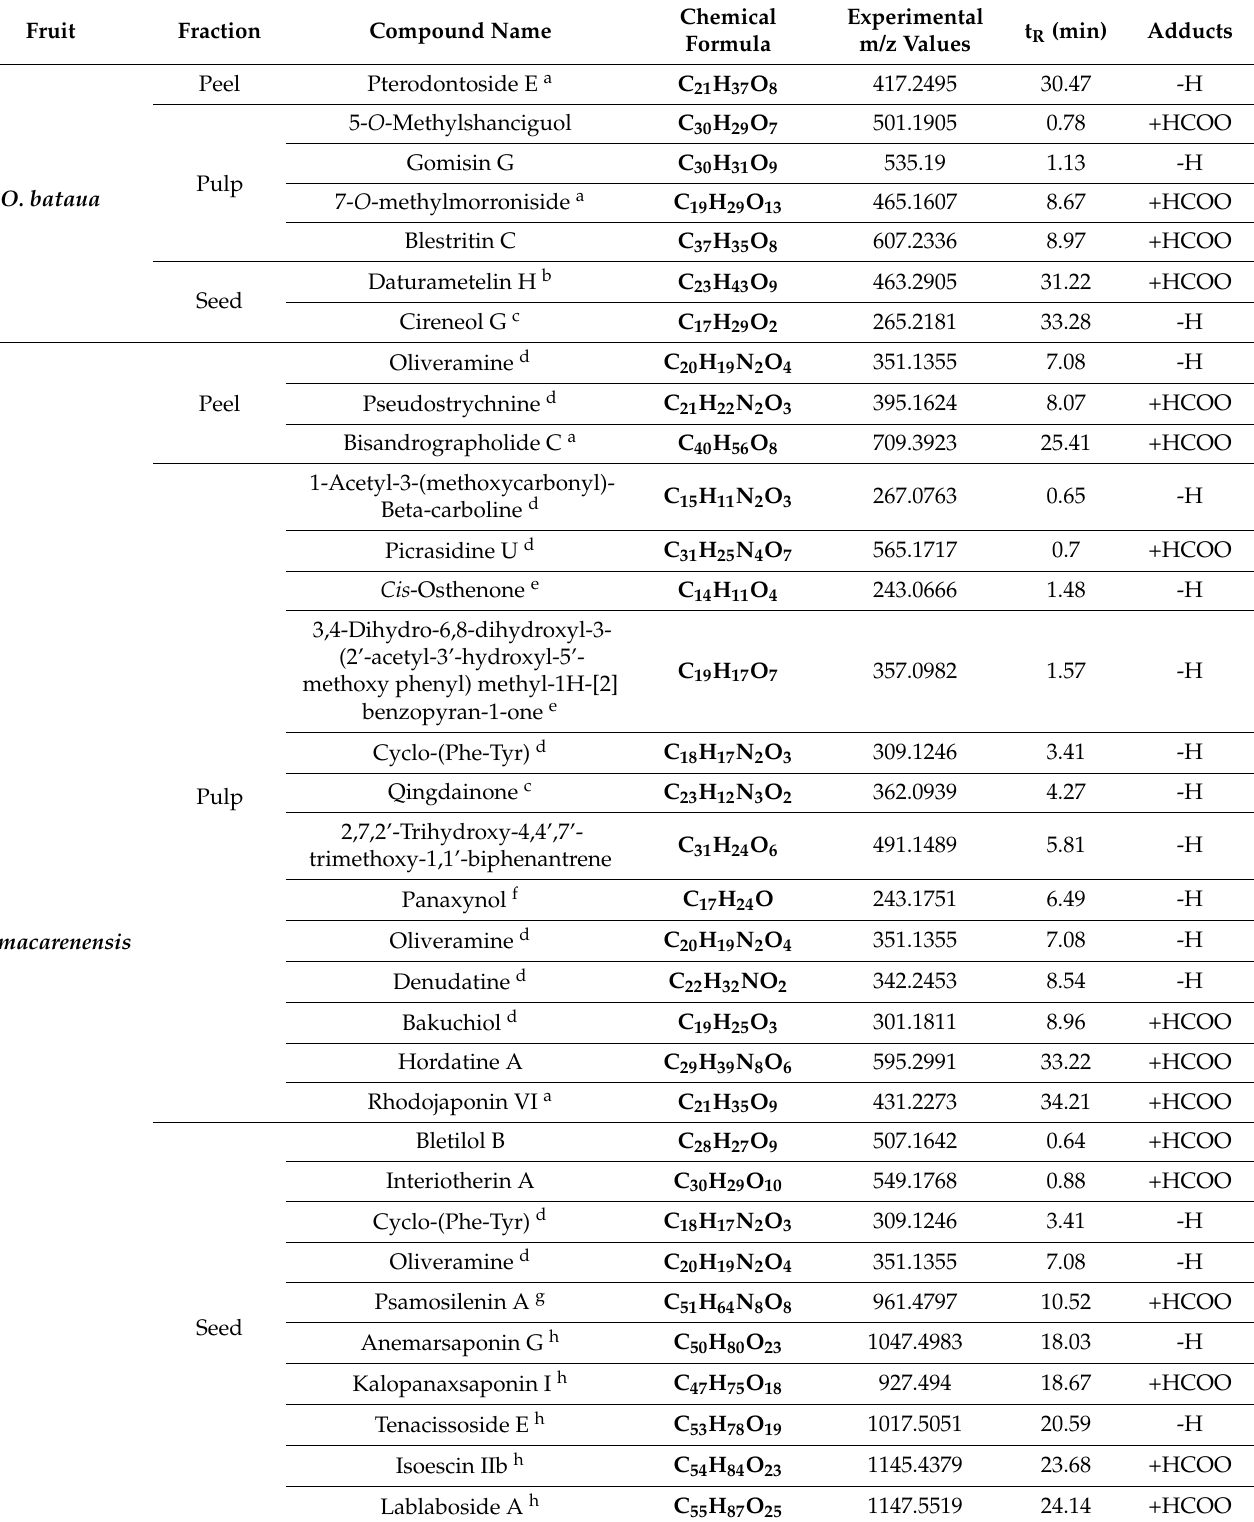
Table 6. Identified compound in O. bataua and G. macarenensis using UPLC-QTOF-MS analysis.